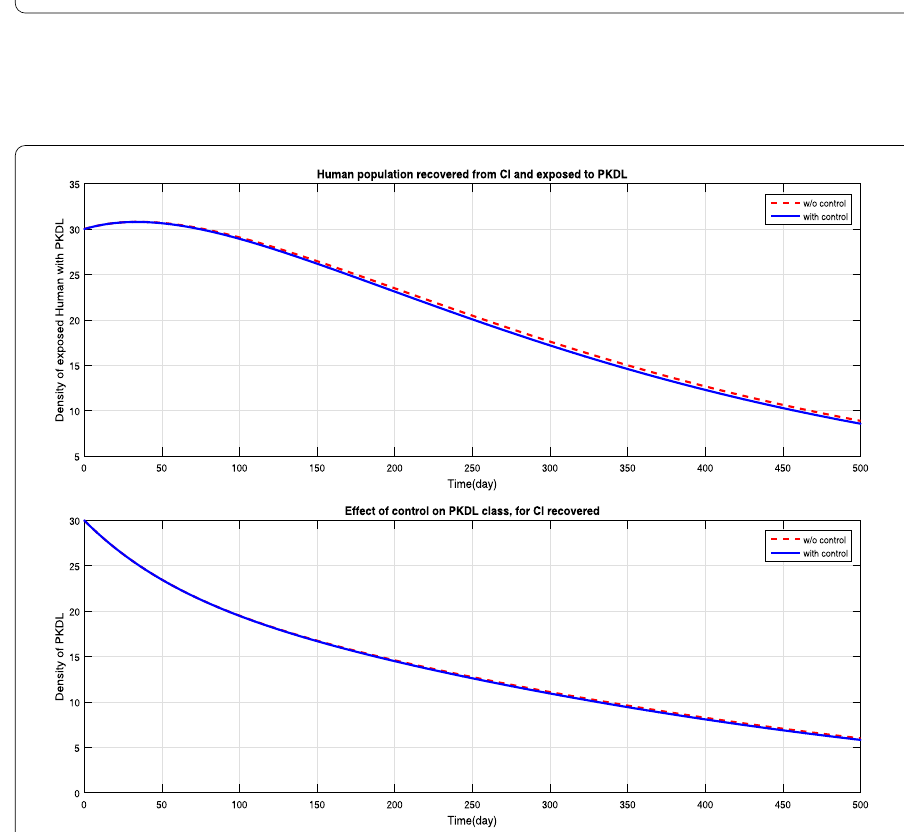
Figure 8 Comparison of behaviors with and without control in case of E 123 and P